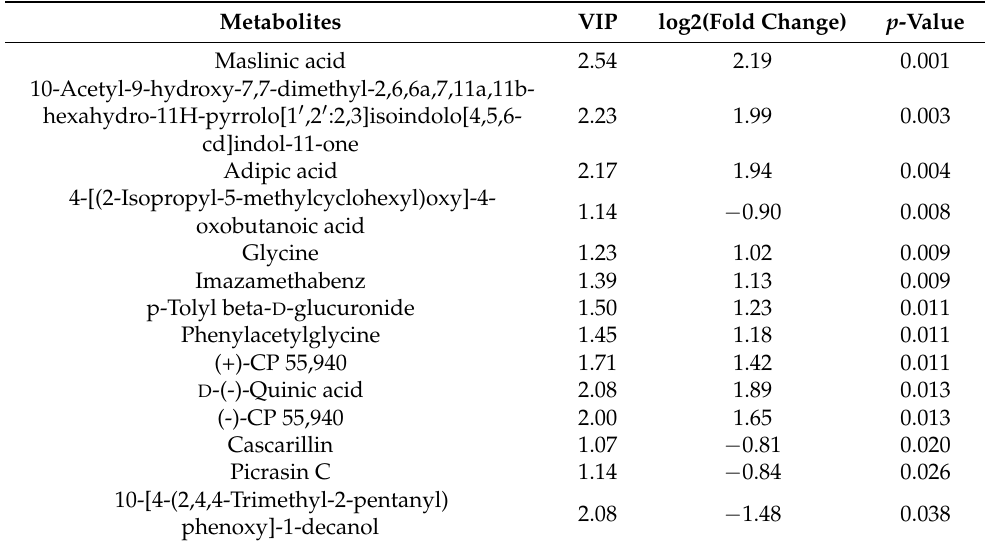
Table 5. The results of differentially expressed metabolites in negative ion mode with VIP > 1 and p < 0.05 in plasma of piglets exposed to G. elegans based on